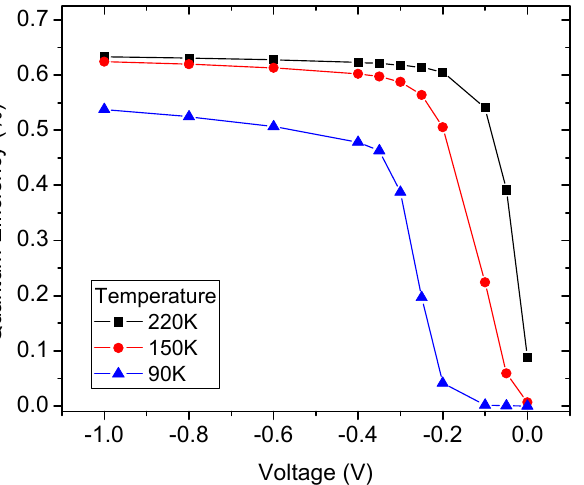
Figure 9. Quantum efficiency (QE) at λ = 3.4 µ m of the deep-etched photodetector for T = 90, 150 and 220 K versus applied bias. At T = 150 K, the QE is equal to 60 % at the operating bias (V = − 0.4 V).